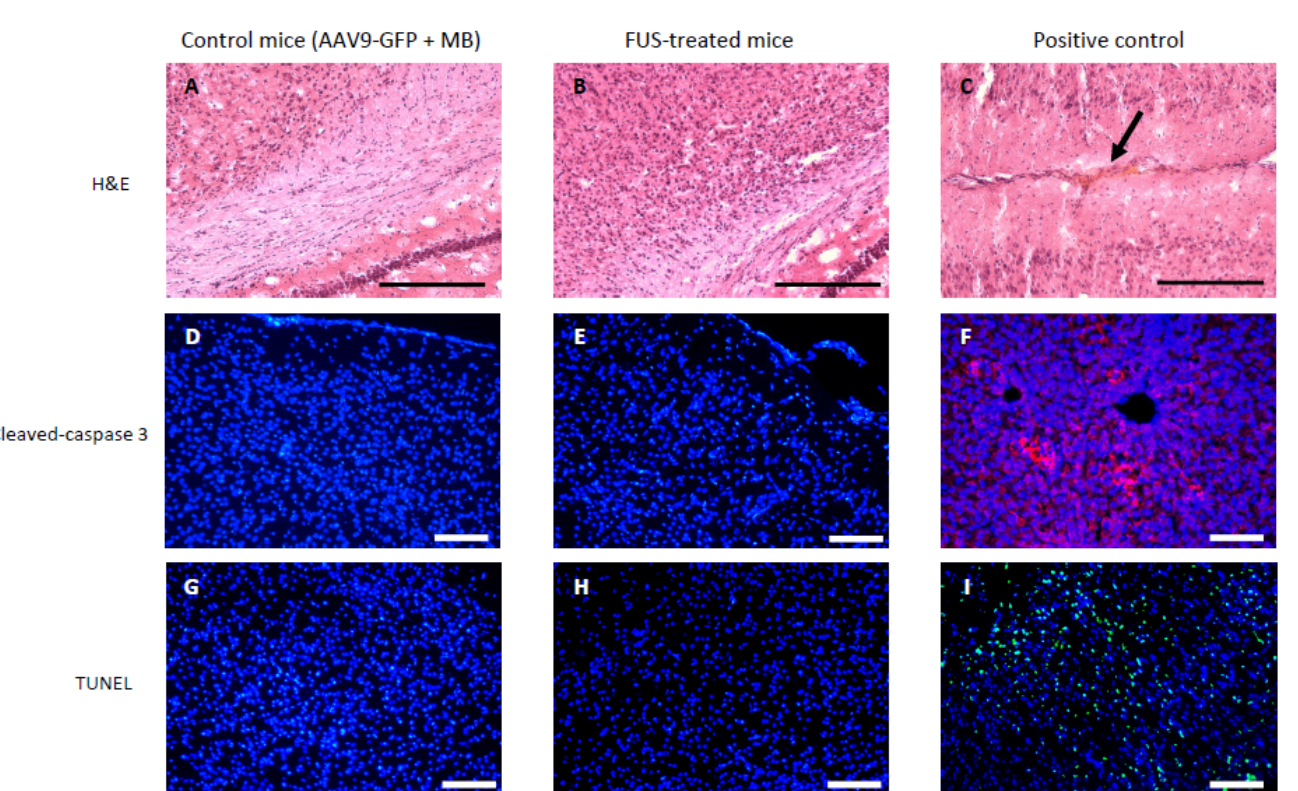
Figure 3. Safety studies 24 h after FUS treatment did not show any apoptosis or hemorrhages in mice brains. ( A – C ): Hematoxylin-eosin staining of mice that had FUS treatment after AAV9-GFP and microbubbles (MB) injections ( B ) showed no difference with control mice (only AAV9-GFP and MB injections) ( A ). Images are representative pictures at the corpus callosum and CA1 levels. Red blood cells are indicated with an arrow on the positive control image ( C ). ( D – F ): Cleaved- caspase 3 immuno-fluorescent red staining is absent in both control ( D ) and FUS-treated mice ( E ). Images are representative pictures in the striatum. Liver sections were used as a positive control ( F ). Cell nuclei are counterstained by DAPI staining (blue color). ( G – I ): TUNEL assay did not show signs of apoptotic cells in both control ( G ) and FUS-treated mice ( H ). Images are representative pictures showing TUNEL staining (green color), DNAse-treated brain sections were used as a positive control ( I ). Images are representative pictures in the striatum. Cell nuclei are counterstained by DAPI staining (blue color). The scale bar represents 100 μ m ( n = 3 for control mice and n = 3 for the FUS-treated mice).